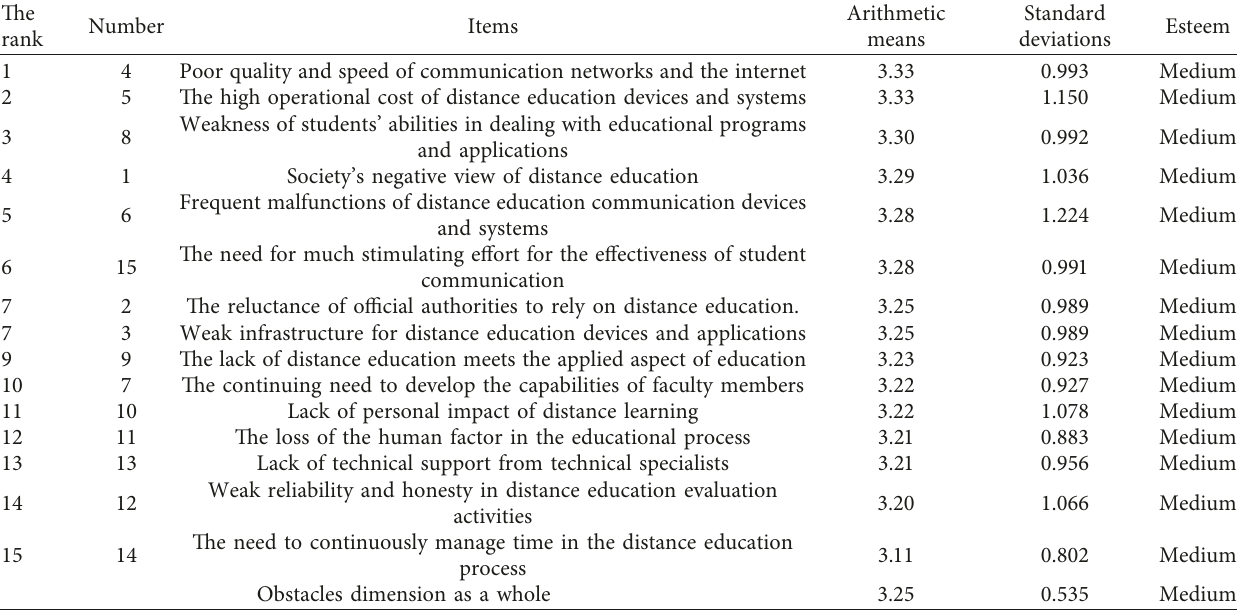
Table 6: Arithmetic means and standard deviations of the obstacles dimension items, arranged in descending order.